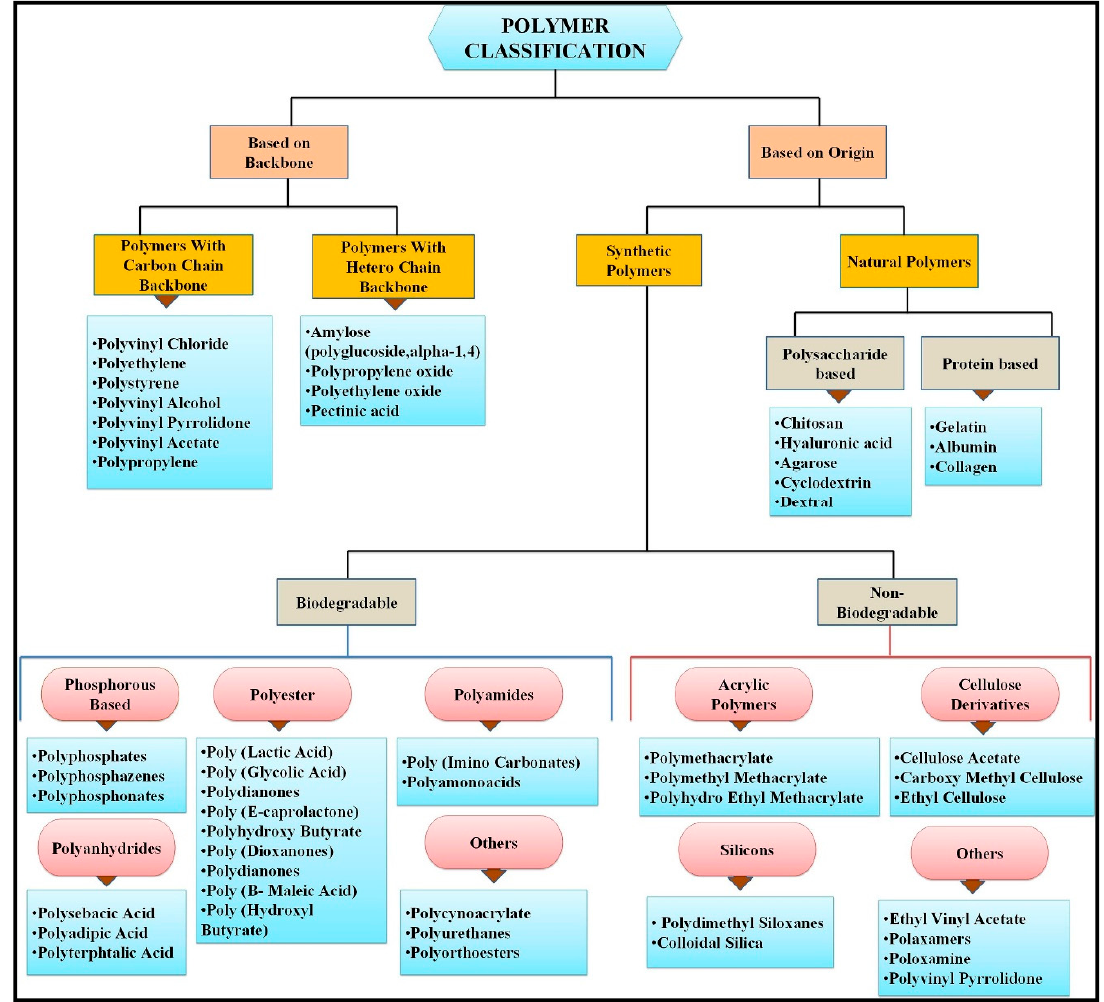
Figure 2. Schematic of polymer classification. Reference is taken from [35]. Copyright ©2019, Elsevier.